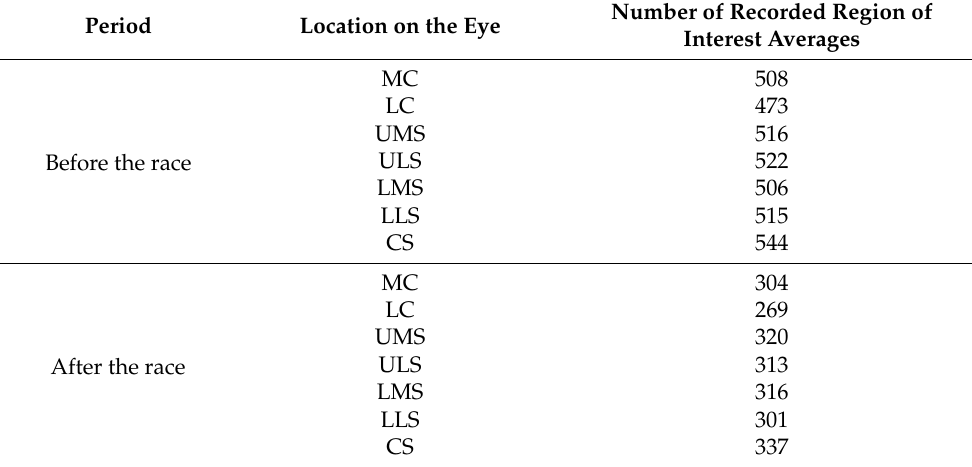
Figure 2. Infrared image of a greyhound viewed using the ResearchIR Max software. The red boxes on the left eye represent the seven locations in which the Region of Interest averages were recorded. The centre of the eye was located at the intercept of the black lines. Table 2. The number of Region of Interest averages recorded for each location on the eye, both before and after the